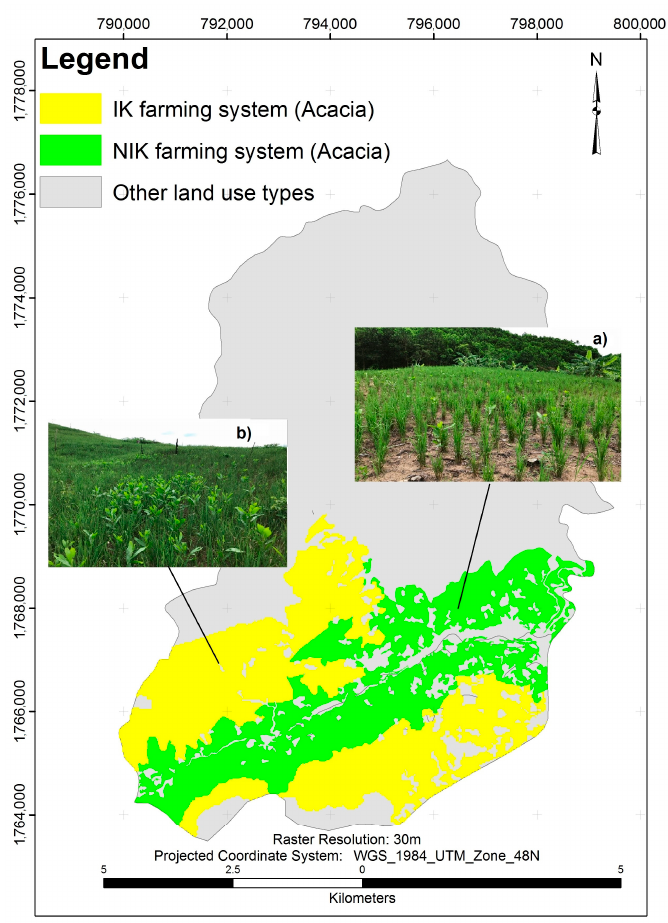
Figure 2. The indigenous knowledge (IK) farming system ( a ); and non-indigenous knowledge (NIK) farming system ( b ).